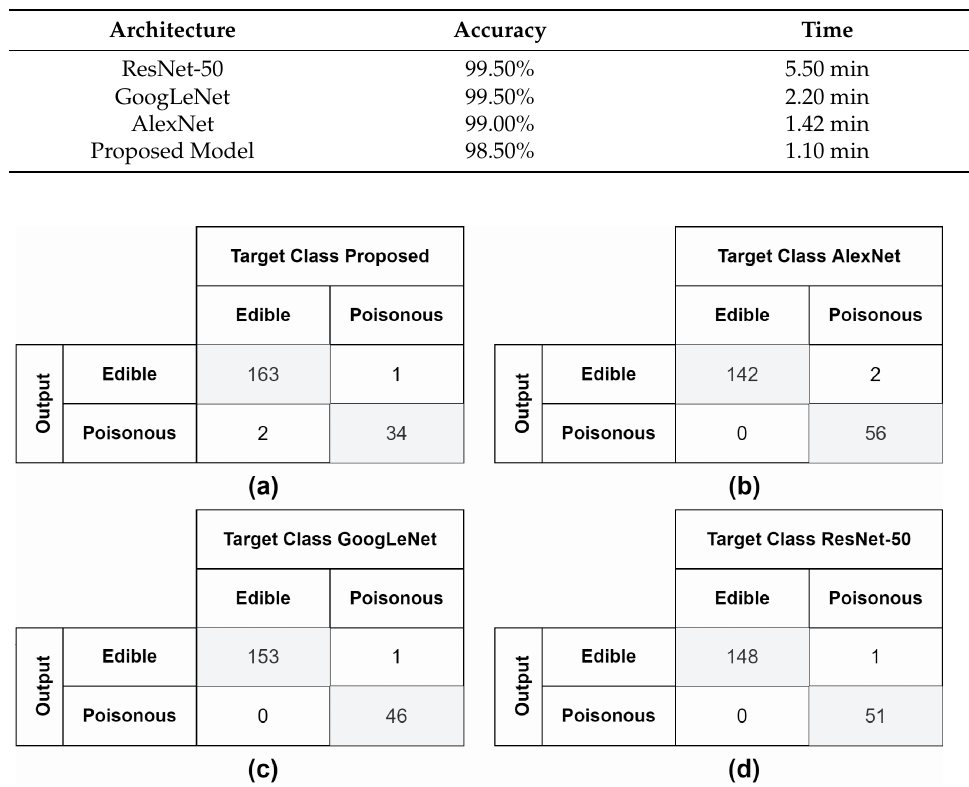
Table 5. Analysis of the CNN test results.